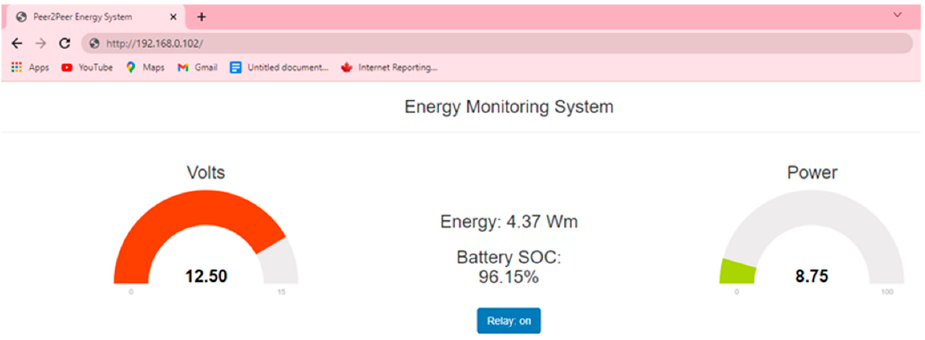
Figure 19. Energy offered by sellers.